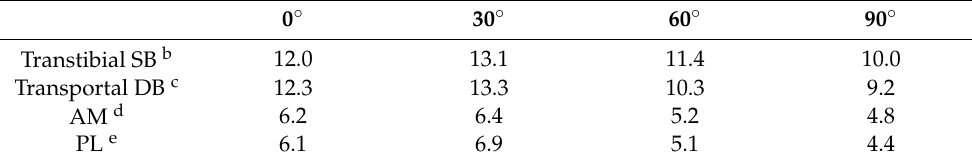
Table 1. Graft stress during knee flexion combined with a 134 N anterior tibial load. a 0